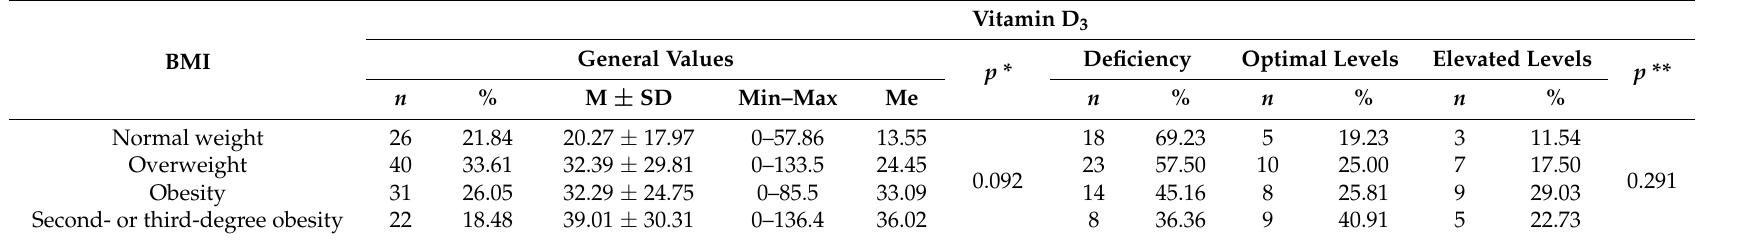
Table 1. Analysis of vitamin D 3 levels with regard to Body mass index (BMI).